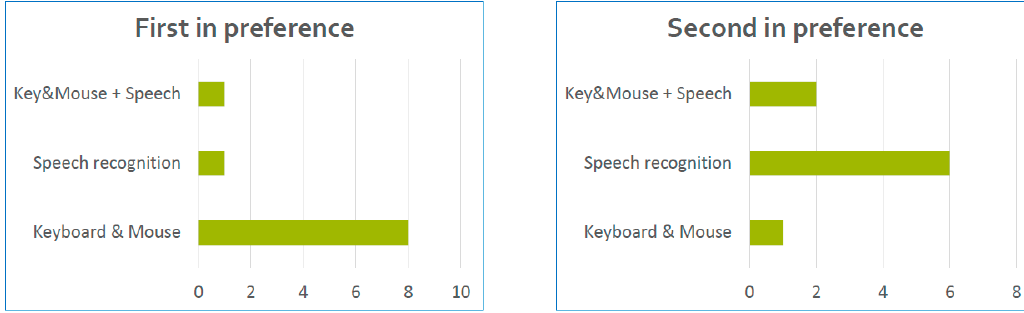
Figure 11. Preferred interaction modes as indicated by participants.